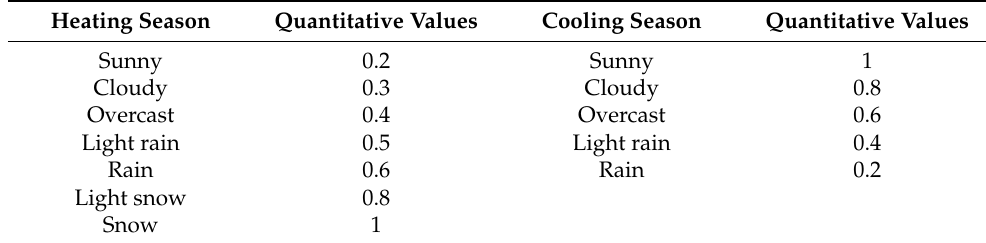
Table 1. Quantitative values of weather in different energy supply seasons. Heating Season Quantitative Values Cooling Season Quantitative Values Sunny 0.2 Sunny 1 Cloudy 0.3 Cloudy 0.8 Overcast 0.4 Overcast 0.6 Light rain 0.5 Light rain 0.4 Rain 0.6 Rain 0.2 Light snow 0.8 Snow